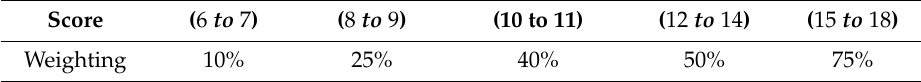
Table 2. Expert weighting according to the score